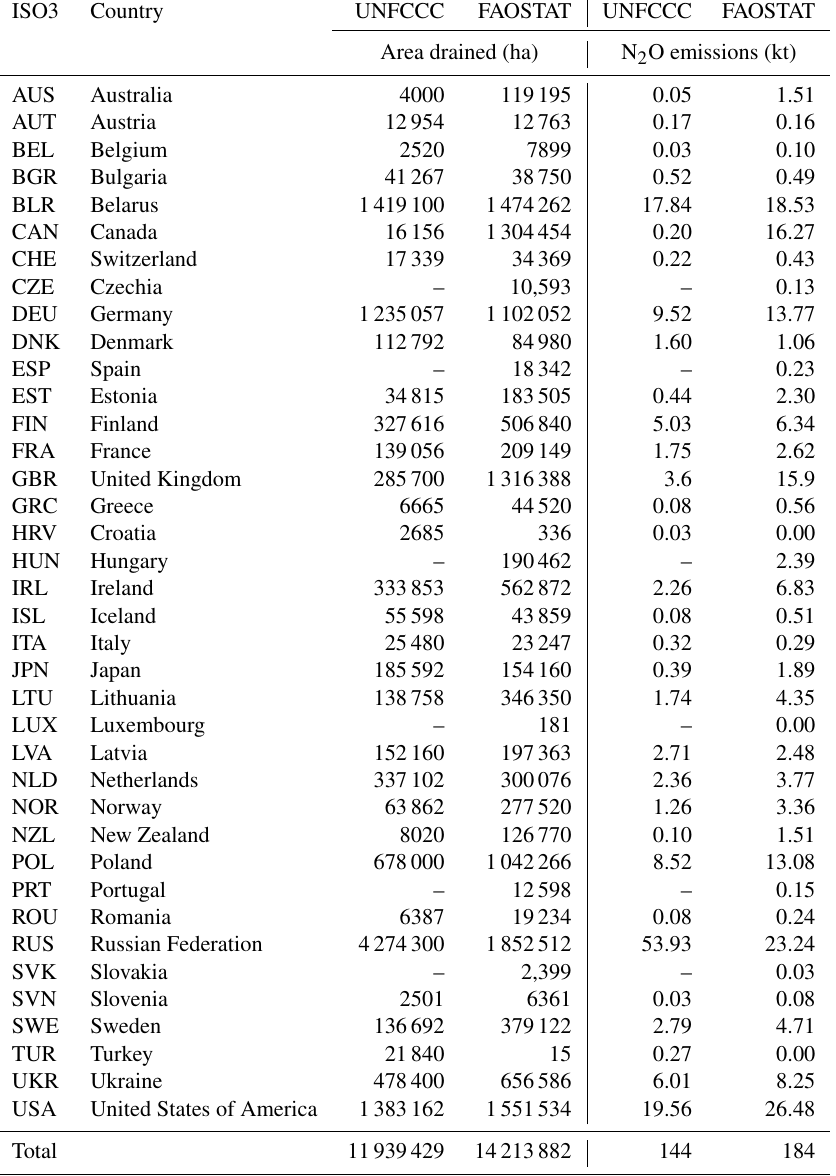
Table B2. FAOSTAT estimates and UNFCCC-reported country data: area drained and N 2 O (kt) emissions, by country in Annex I group ∗ ,